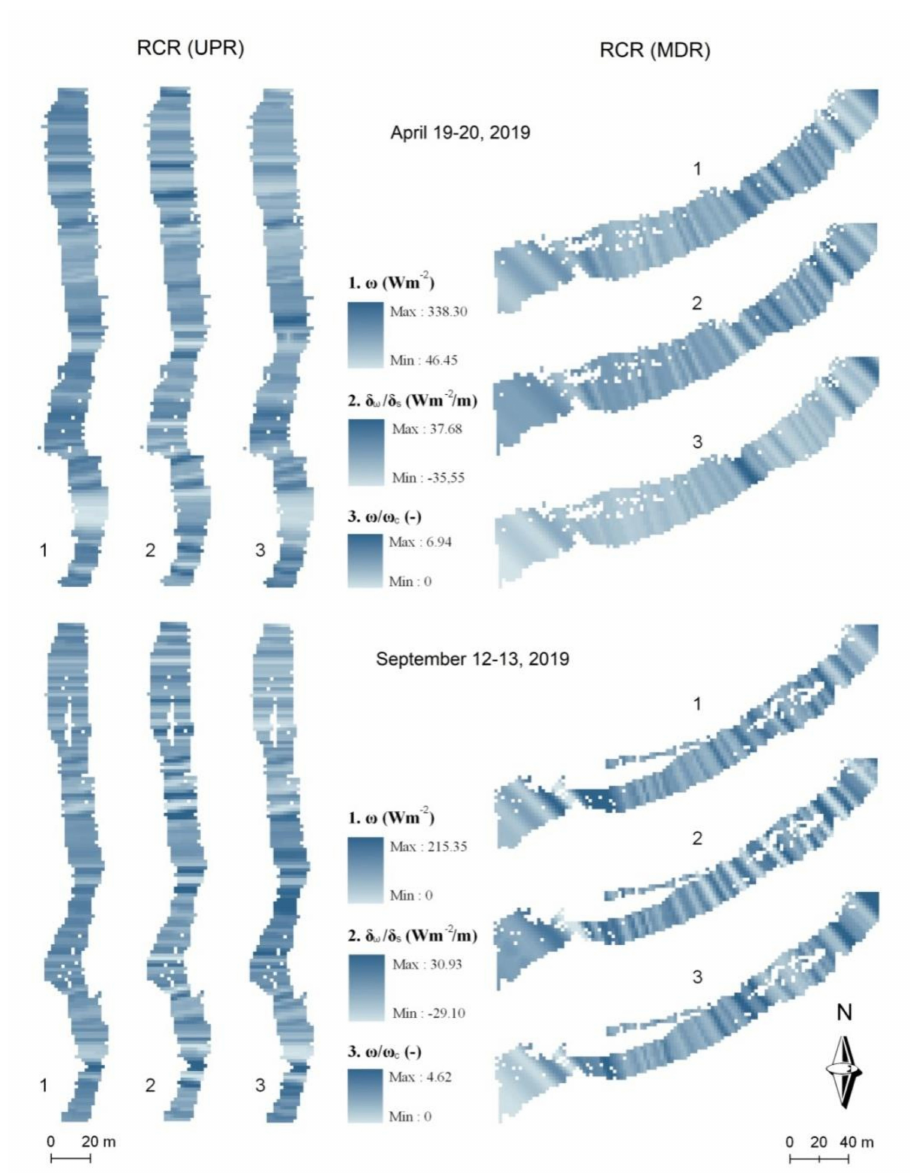
Figure 6. Values of ω , ∂ ω / ∂ s, and ω / ω c obtained for each cell by spatial interpolation of HEC-RAS data related to equidistant (2.0–3.5 m) cross-sections in the RCR(UPR) and RCR(MDR). Peak floods of 19–20 April 2019 (upper graph) and 12–13 September, 2019 (lower graph). The maximum color limits encompass the 95% of the data